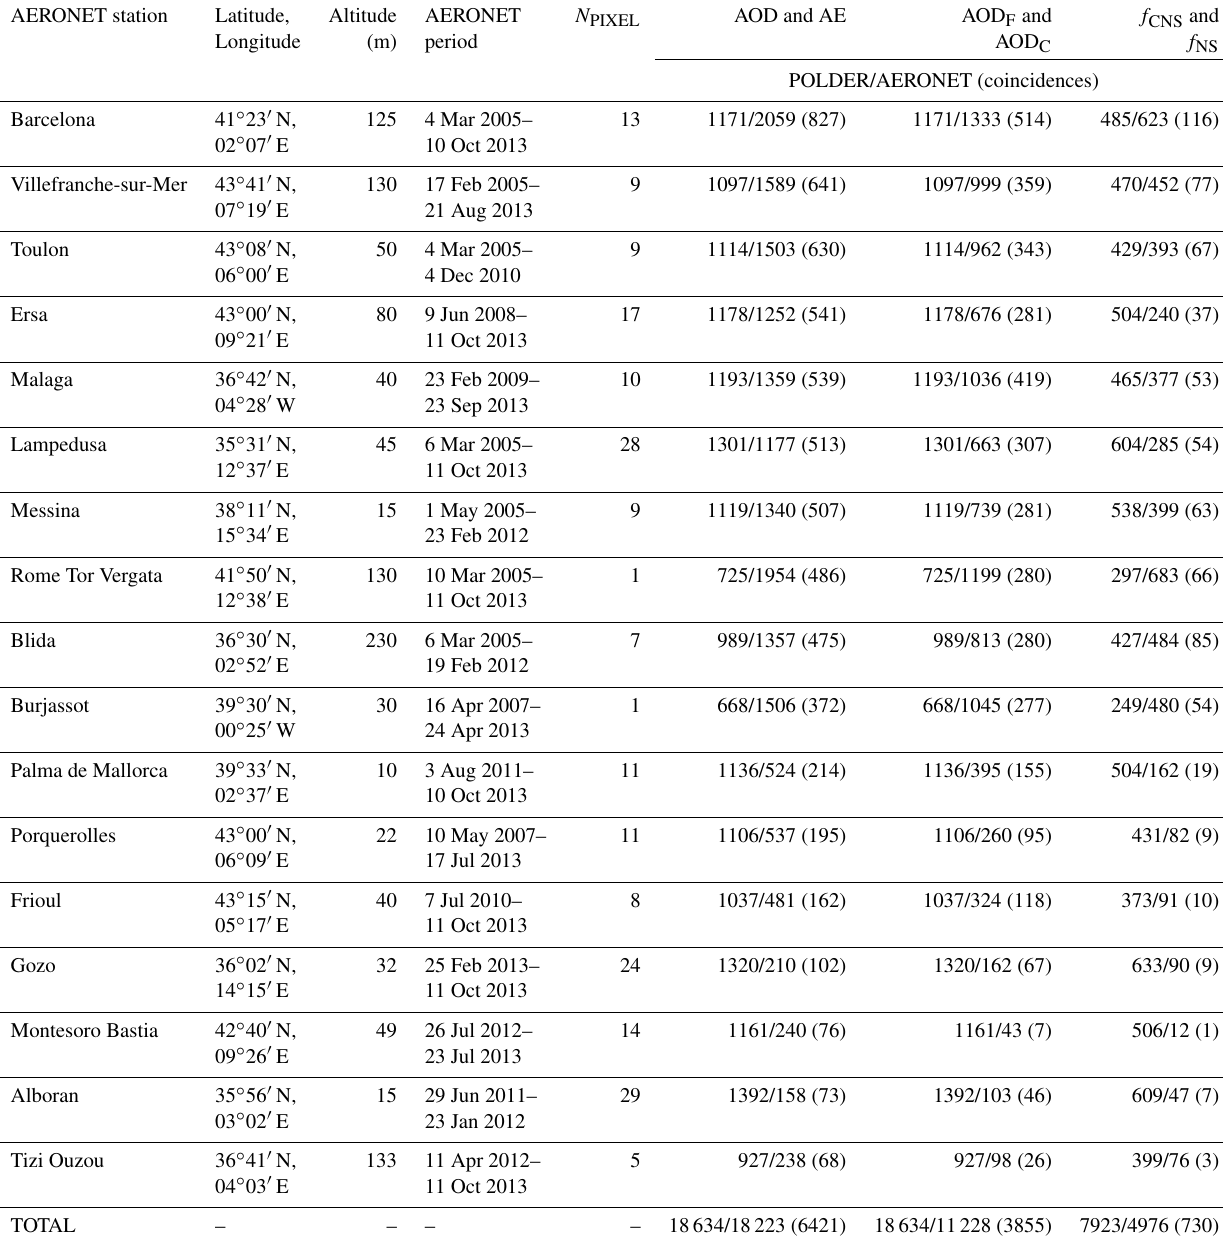
Table 1. List of AERONET stations available in the western Mediterranean region retained for this study. The number of ocean POLDER pixel within 0.5 ◦ from the position of the station is indicated ( N PIXEL ). The number of observations by POLDER-3 and AERONET between March 2005 to October 2013, and the number of coincident days (within brackets) are also